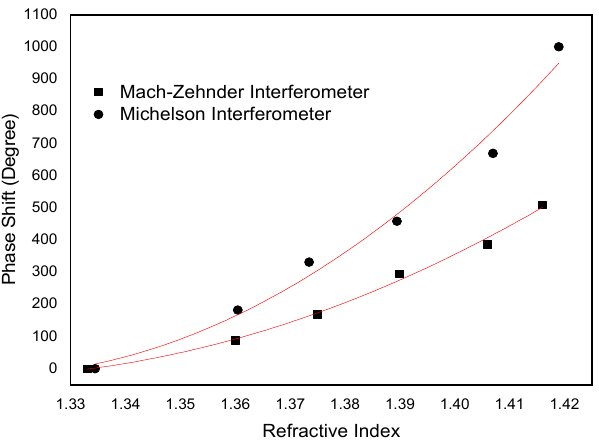
Figure 13. Response comparison between a Michelson and Mach–Zehnder interferometric phase changes due to refractive index variations.